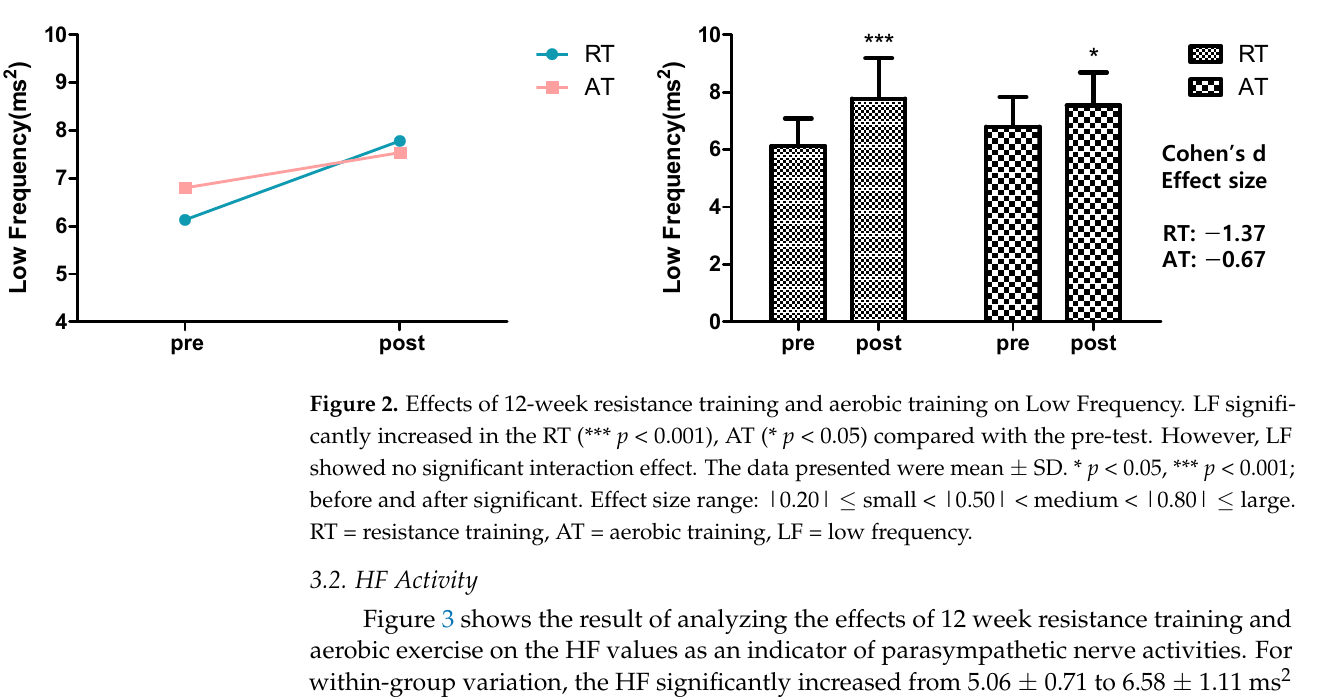
Figure 3. Effects of 12-week resistance training and aerobic training on Low Frequency. HF has significantly increased in the RT (*** p < 0.001) compared to the pre-test. HF showed a significant interaction effect (## p < 0.01). The data presented were mean ± SD. *** p < 0.001; before and after significant. ## p < 0.01; interaction significant. Effect size range: |0.20| ≤ small < |0.50| < medium < |0.80| ≤ large. RT = resistance training, AT = aerobic training, HF = high frequency. 3.3. LF/HF Ratio Figure 4 shows the result of analyzing the effects of 12-week resistance training and aerobic exercise on the LF/HF ratio as an indicator of the autonomic nervous system’s balance. No significant change was found in the LF/HF ratio in the resistance training